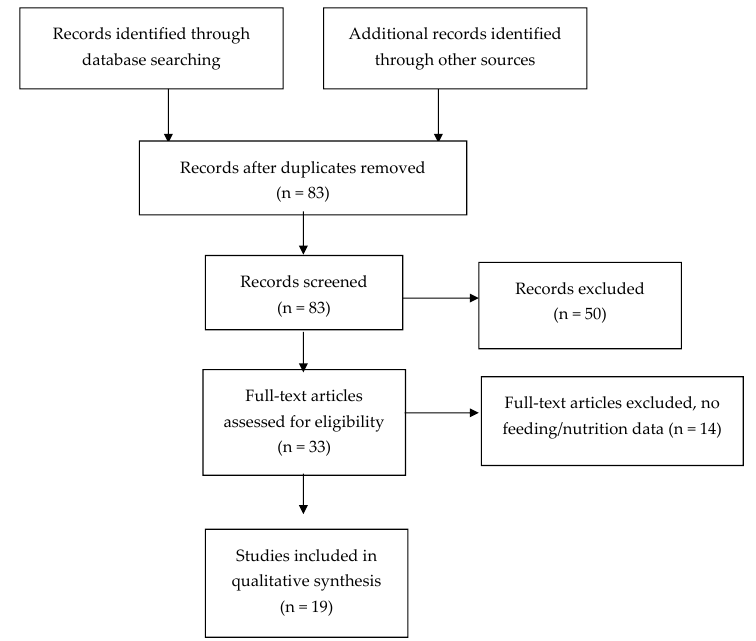
Figure 1. Flowchart of systematic review results.